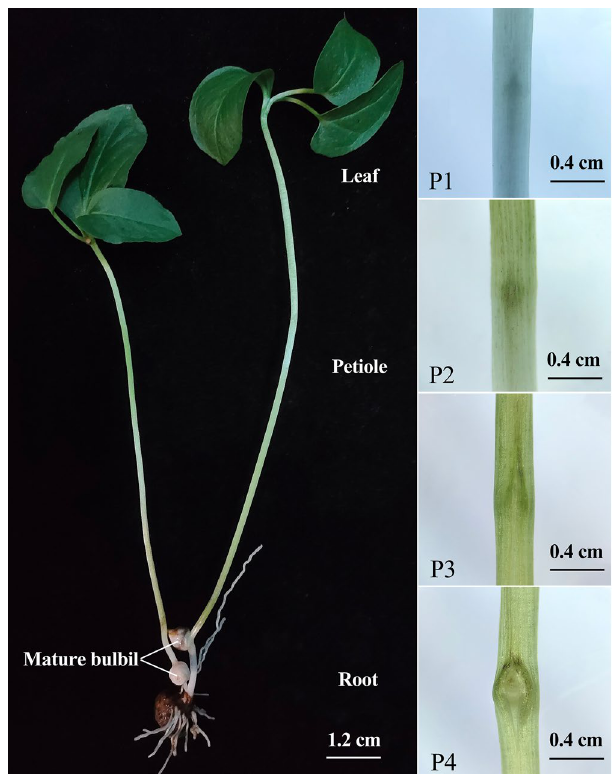
Figure 1. Four stages of early bulbil development and mature bulbil. ( a ). Intact plants and mature bulbil. ( b ). Four periods of sampling: P1 = Period 1; P2 = Period 2; P3 = Period 3; P4 = Period